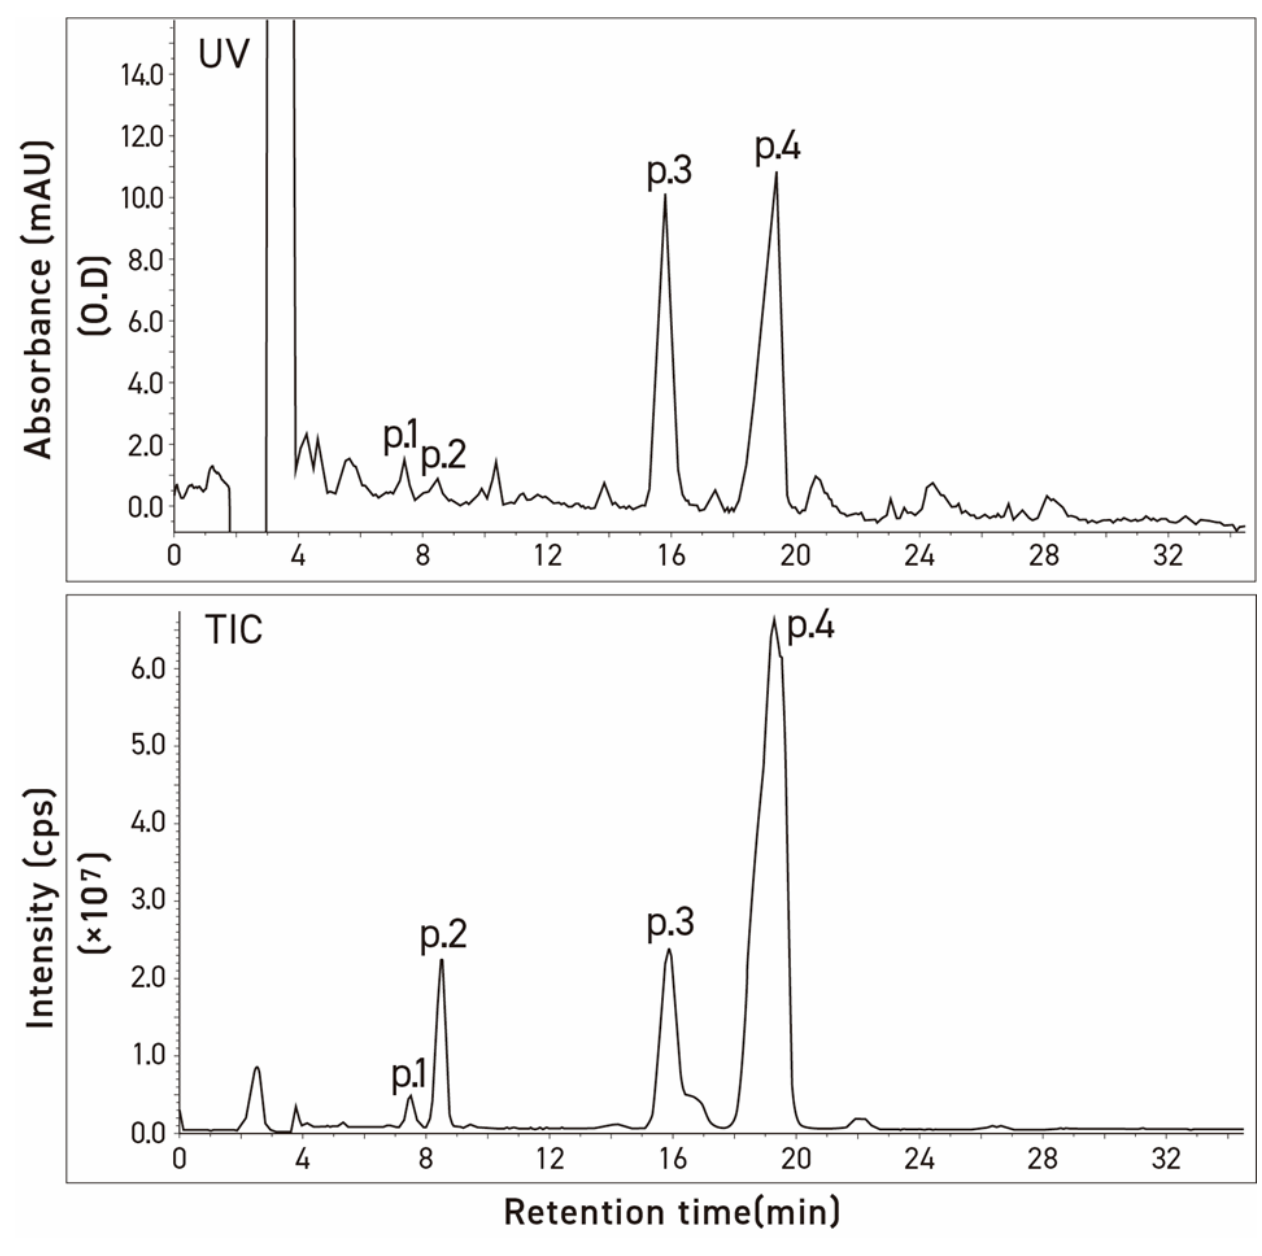
Figure 3. Chromatograms of commercial α-tomatine by two detection methods, UV absorbance at 208 nm (UV) and total ion (TIC). Conditions: column, Inertsil ODS-3v [5 μm, 4.0 mm × 250 mm]; column temp, 20 °C; injection volume, 20 μL; mobile phase, acetonitrile/20 mM ammonium acetate in water (35:65, v / v ); flow rate, 0.8 mL/min.